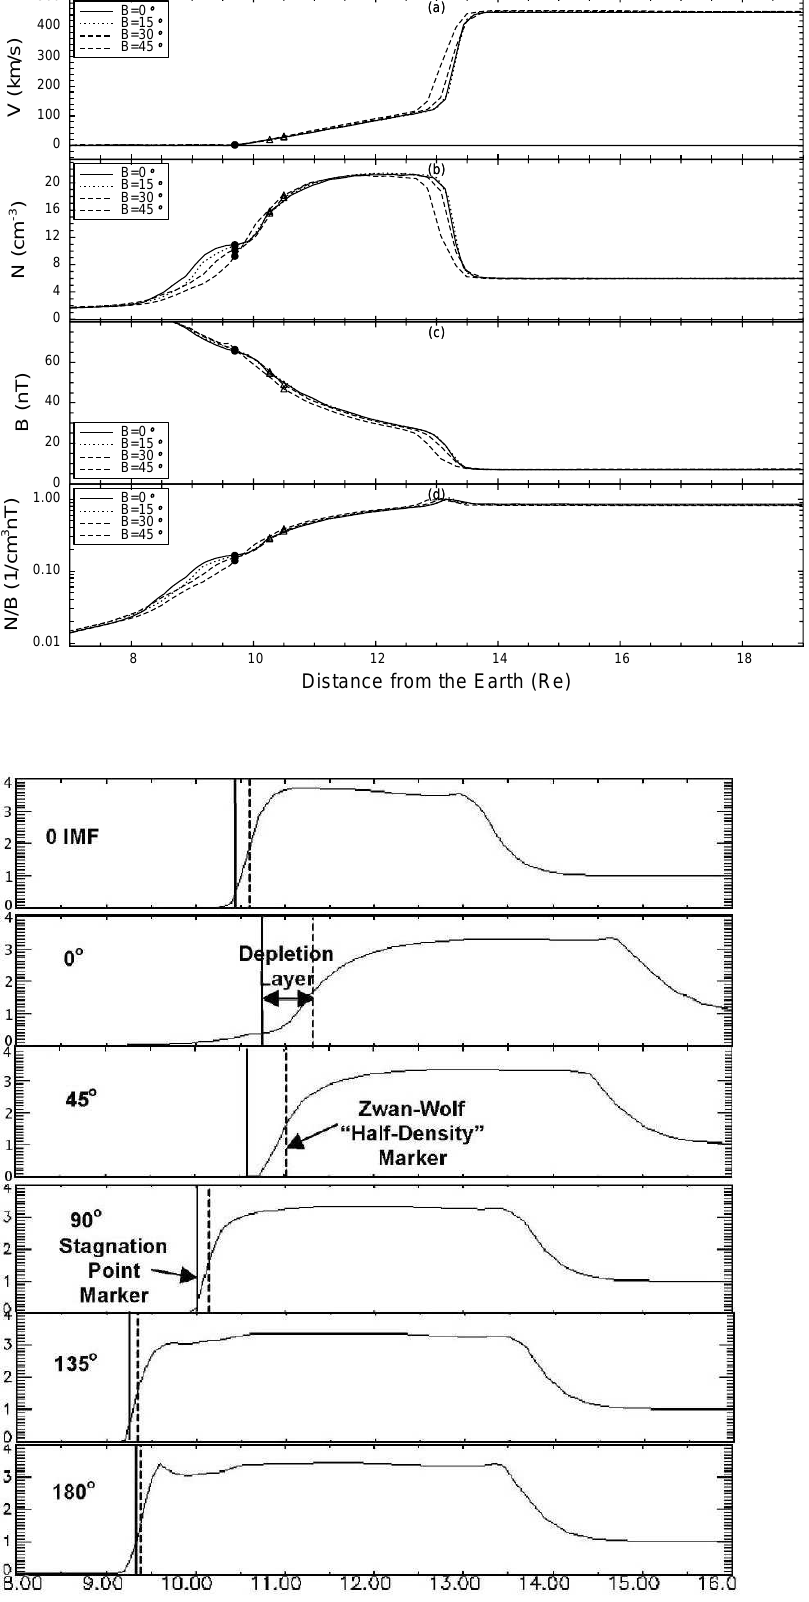
Fig. 11. Taken from Siscoe et al. (2002). Normalized plasma density along the stagnation streamline for dif- ferent IMF conditions. Angles specify the clock angle of the IMF. The two vertical lines in each panel show where the velocity goes to zero (the stagnation point) and where the density drops to half its post-shock value (to determine the thickness of the depletion layer by the Zwan and Wolf